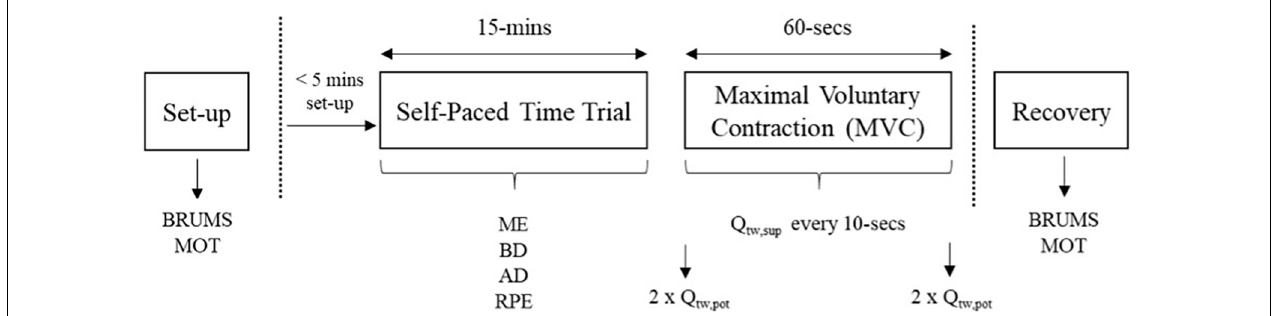
FIGURE 1 | Schematic of main trials. BRUMS, brunel mood scale; MOT, motivation scale; ME, mental effort, Borg CR-100; BD, breathing discomfort, Borg CR-10; AD, arm discomfort, Borg CR-10; RPE, rating of perceived exertion, Borg 6-20 scale; MVC, maximal voluntary contraction; Q tw , pot , resting/potentiated doublet; Q tw , sup , superimposed